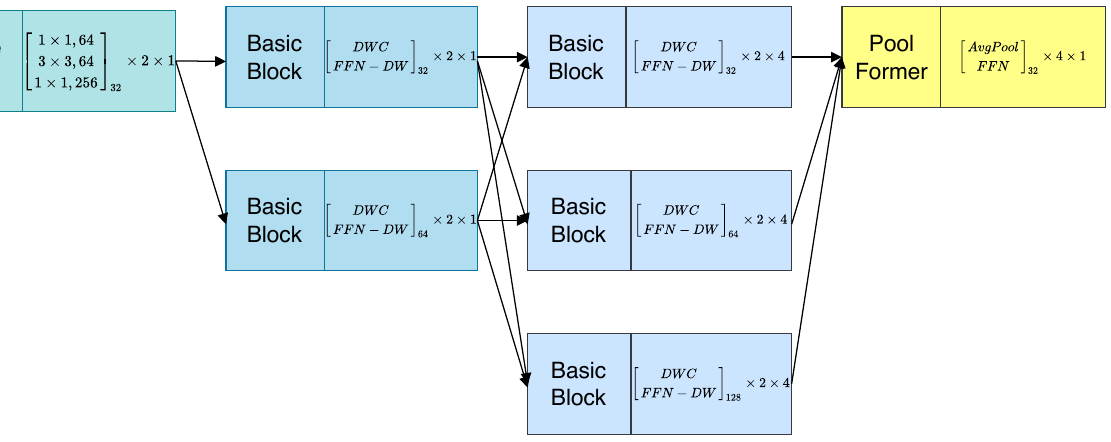
Figure 1. The illustration of the DepthFormer